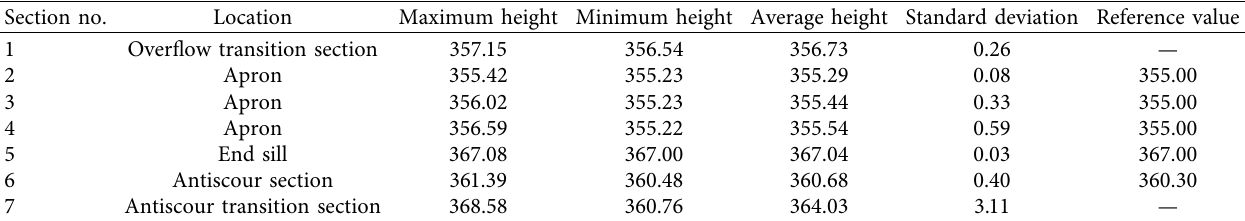
Table 2: Comparison table of elevation parameters among selected sections of the surface outlet stilling basin (unit: m). Section no.